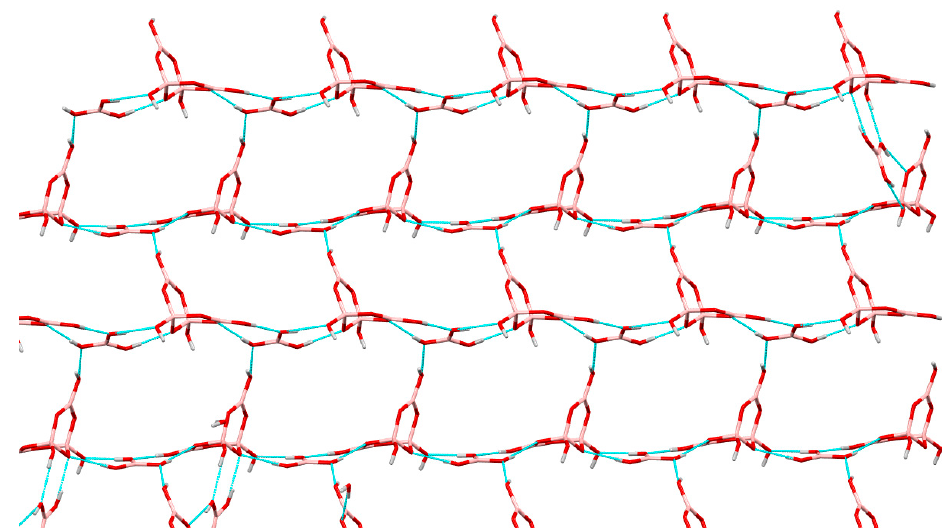
Figure 6. A 2D plane in 9 comprised of alternating B(OH) 3 /[B 4 O 5 (OH) 4 ] 2 − ′ horizontal ′ chains and ′ vertical ′ C 22 (8) crosslinking.